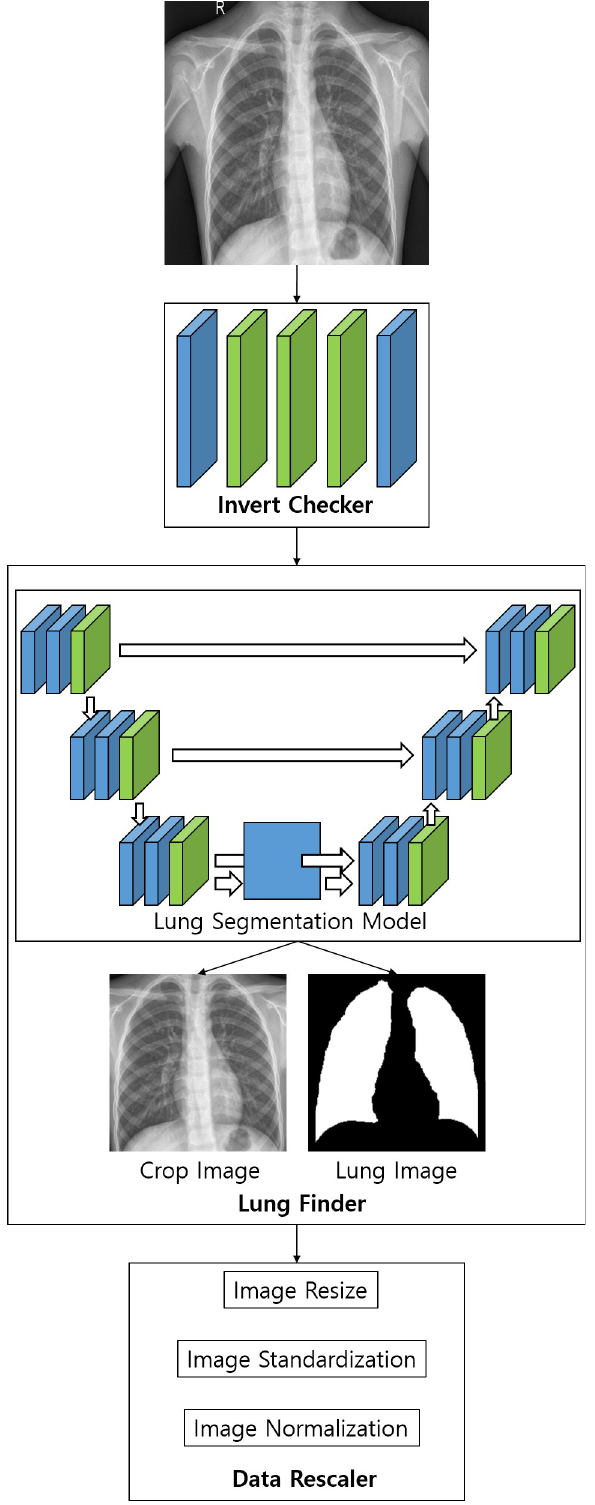
Fig 1. Flow diagram of the pre-processing module process.